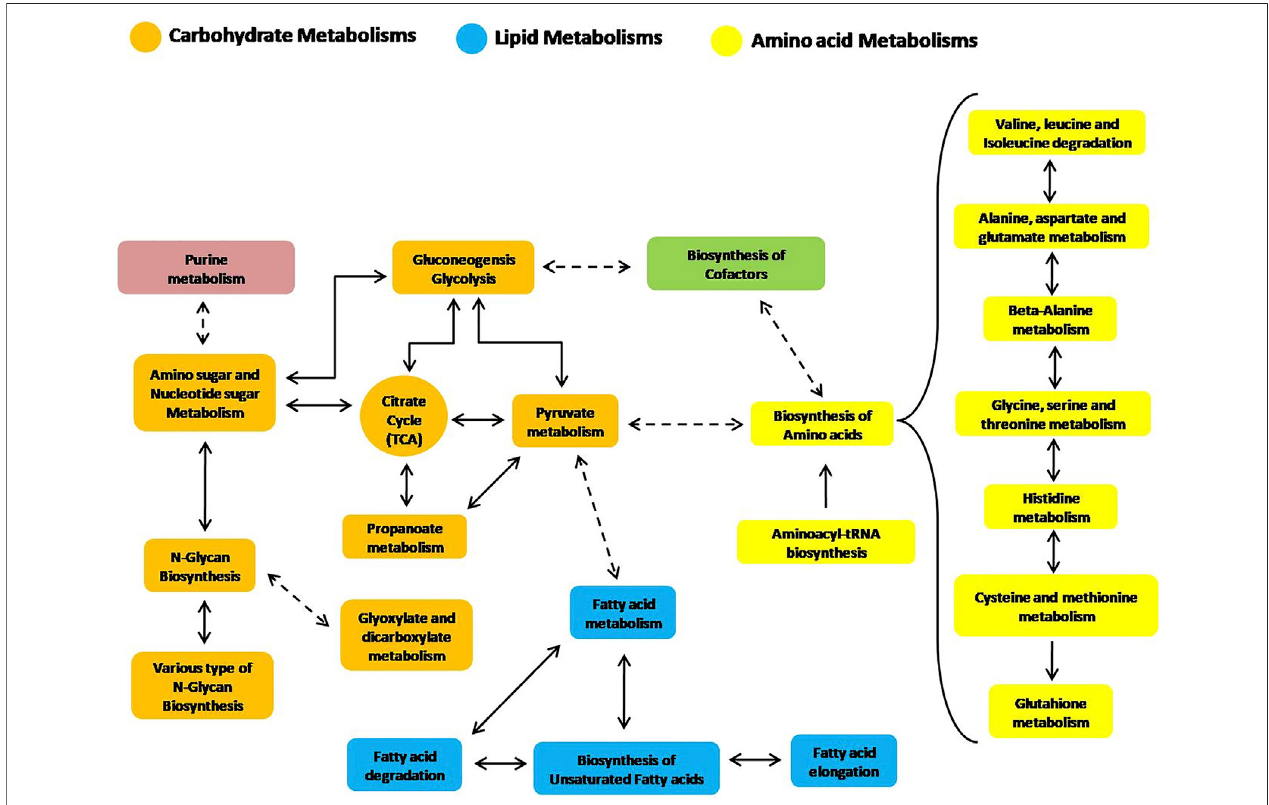
FIGURE 4 | Reconstruction of signi fi cant liver metabolic pathways identi fi ed by an integrated analysis of proteomics and metabolomics data (based on the KEGG pathway module database).